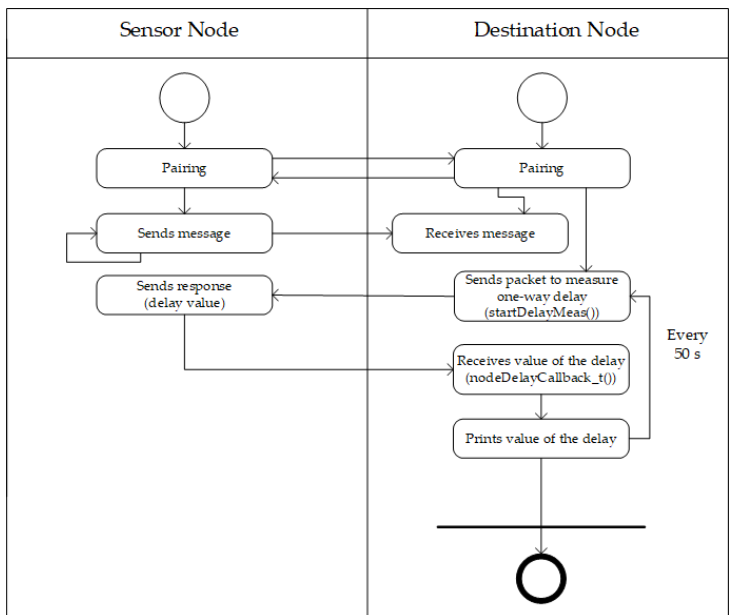
Figure 6. Algorithm used for message exchange and count.